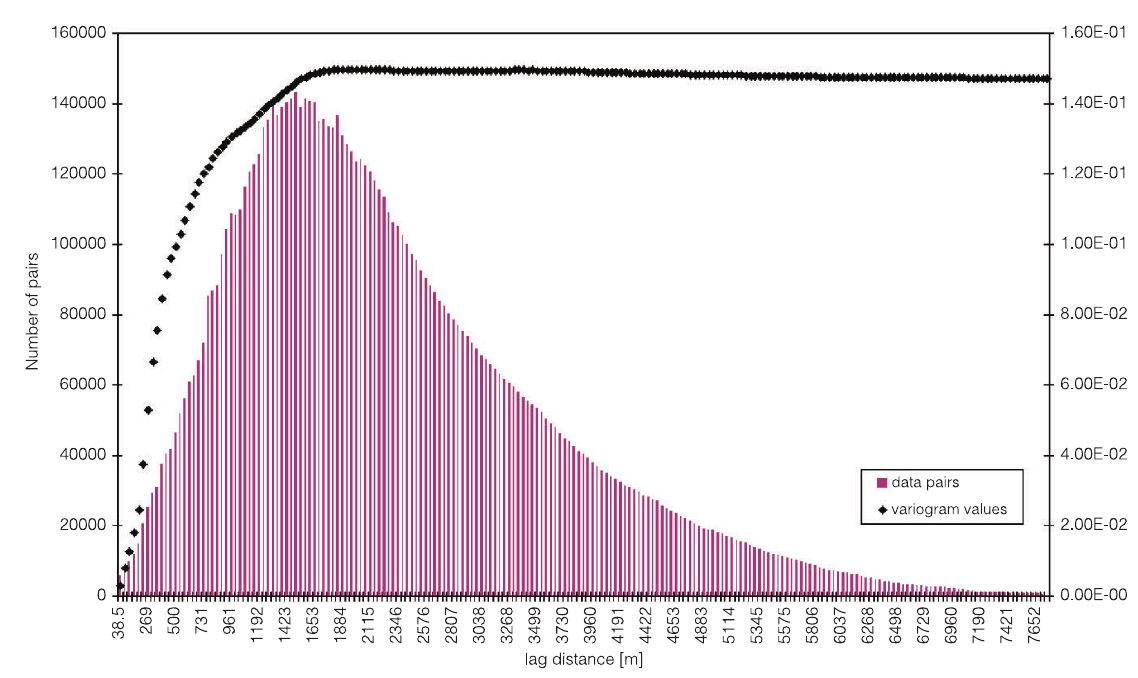
Fig. 8. Isotropic experimental variogram (after geometric scaling) and best fi t curve (Gaussian) for the fl ight